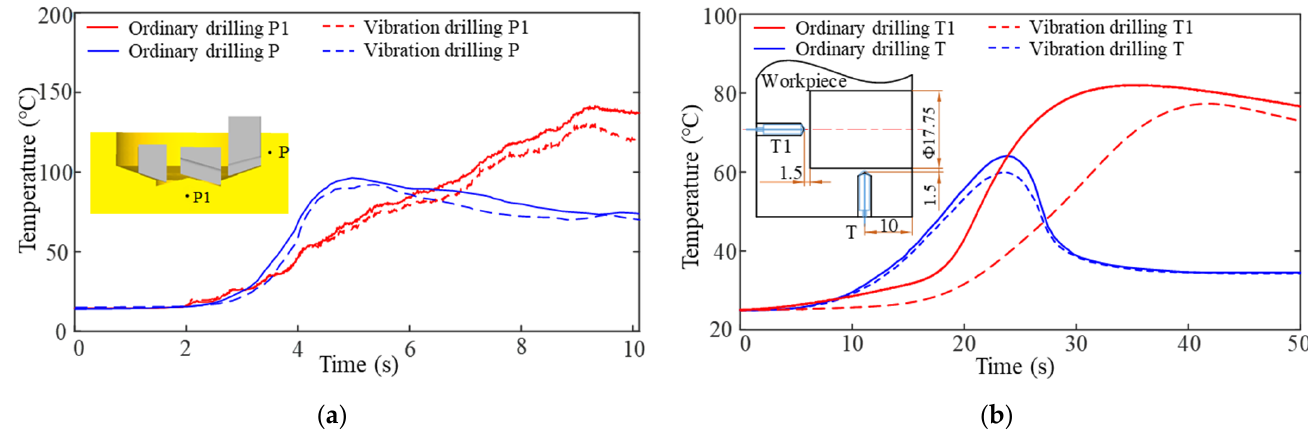
Figure 8. ( a ) Simulated internal temperature rise curve of workpiece by vibration drilling and ordinary drilling; ( b ) Experimental measured changes in the internal temperature of the workpiece by vibration drilling and ordinary drilling.